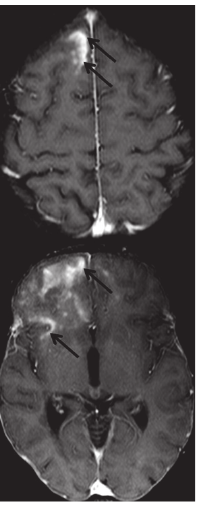
Figure 2: Signs of IRIS at the time of PML diagnosis. 1.5T T1w Gadolinium enhanced MR images are presented. Extensive Gadolinium enhancement suggestive of IRIS (black arrows) was observed at the edge of confluent PML